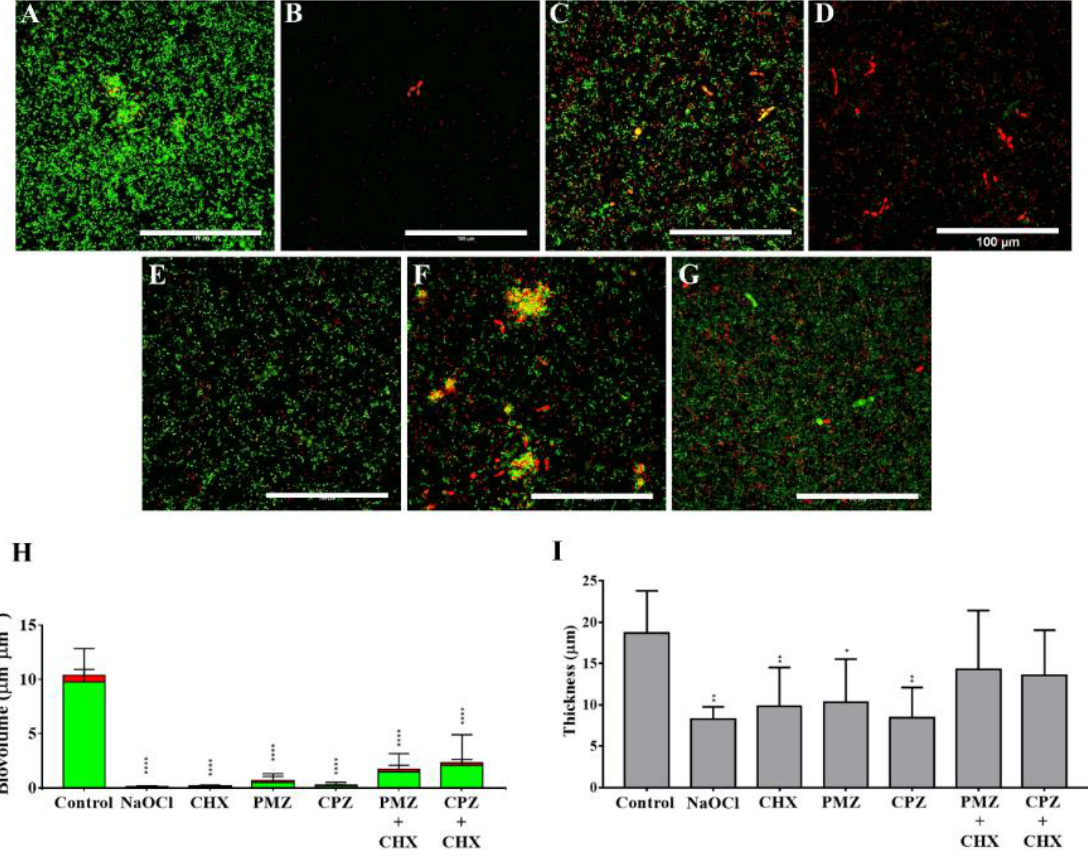
Figure 2. CLSM images of dual-species biofilm after treatment for 10 min with saline ( A ); 25 mg/mL NaOCl ( B ); 20 mg/mL CHX ( C ); 1.28 mg/mL PMZ ( D ); PMZ+ CHX, 0.08 mg/mL + 0.02 mg/mL ( E ); 0.5 mg/mL CPZ ( F ); CPZ + CHX, 0.125 mg/mL+ 0.02 mg/mL ( G ). Magnification 60×. Scale 100 µm. Viable cells are stained in green and dead/damaged cells are stained in red. Biovolume ( H ) and thickness ( I ) of each biofilm were quantified. * represents statistically significant differences when compared to the control. * represents p < 0.05, ** represent p < 0.01 and **** p < 0.001. Data are expressed as mean ± SD.